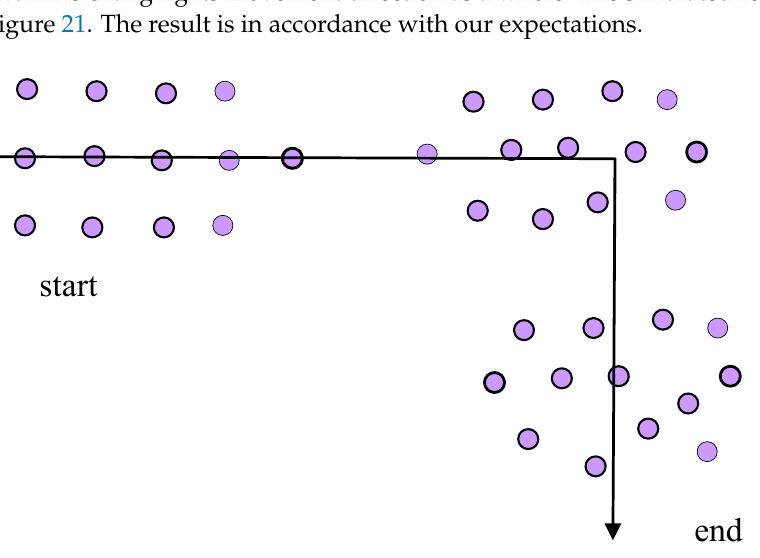
Figure 21. The random organised swarm turning, controlled with one signal.